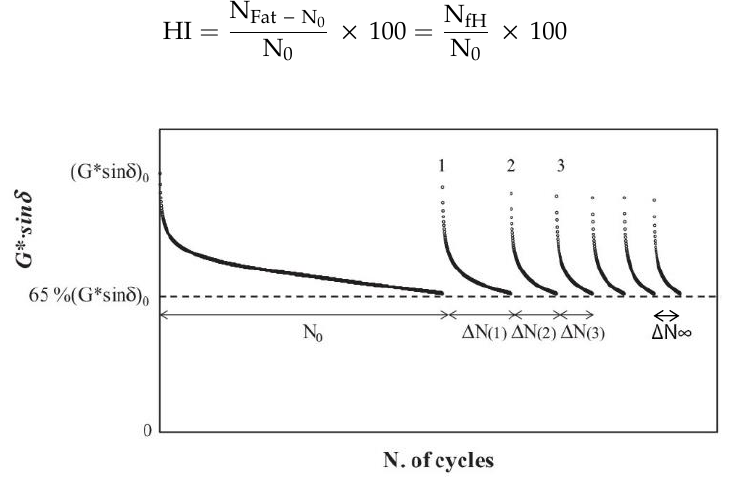
Figure 2. Evolution of |G ∗ | ∙ sin δ versus number of loading cycles: General results.